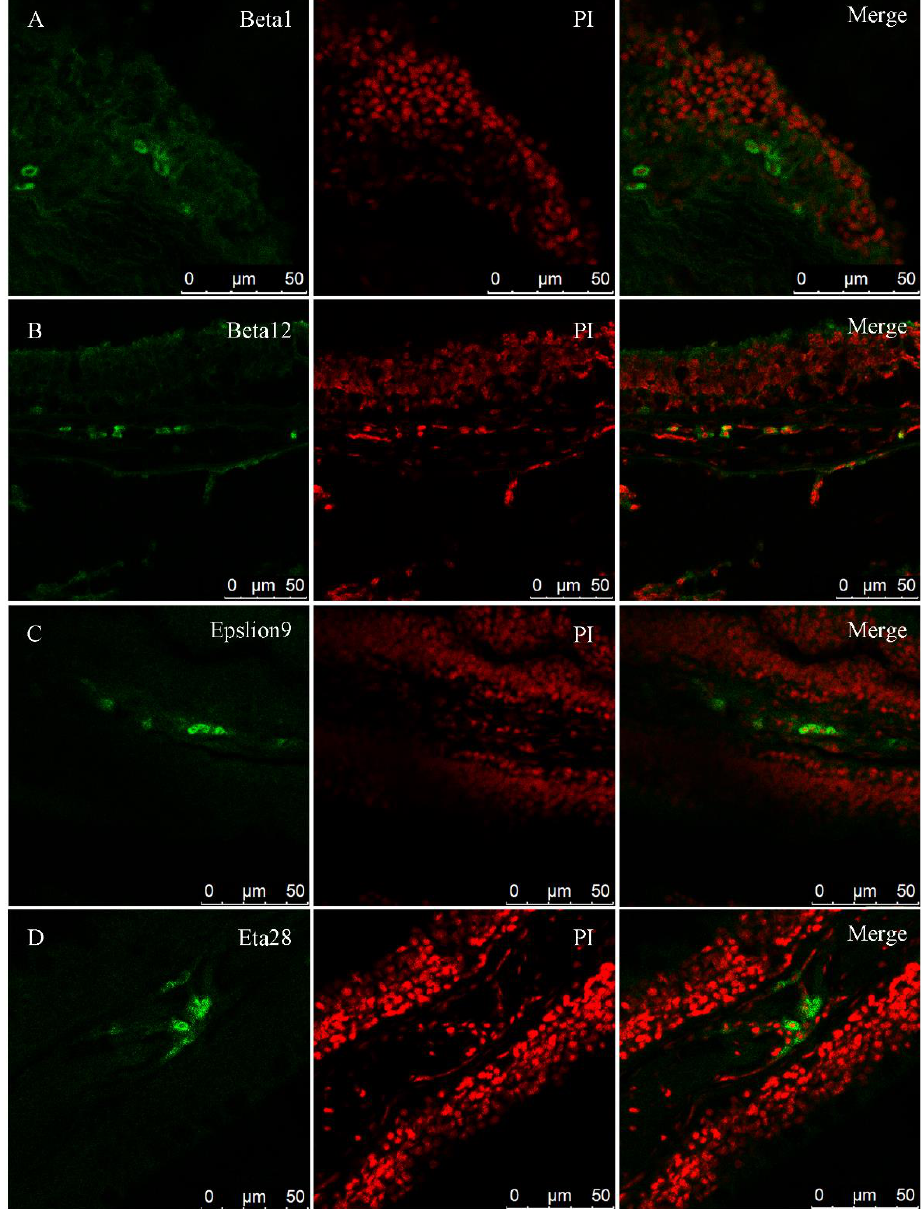
Figure 8. Fluorescence in situ hybridization of four genes ( beta1 , beta12 , epsilon9 , and eta28 ). Green color stained cells are those that express the relevant genes (labeled with Anti-DIG-POD, Fab fragments), whereas nuclei are stained red with propidium iodide.